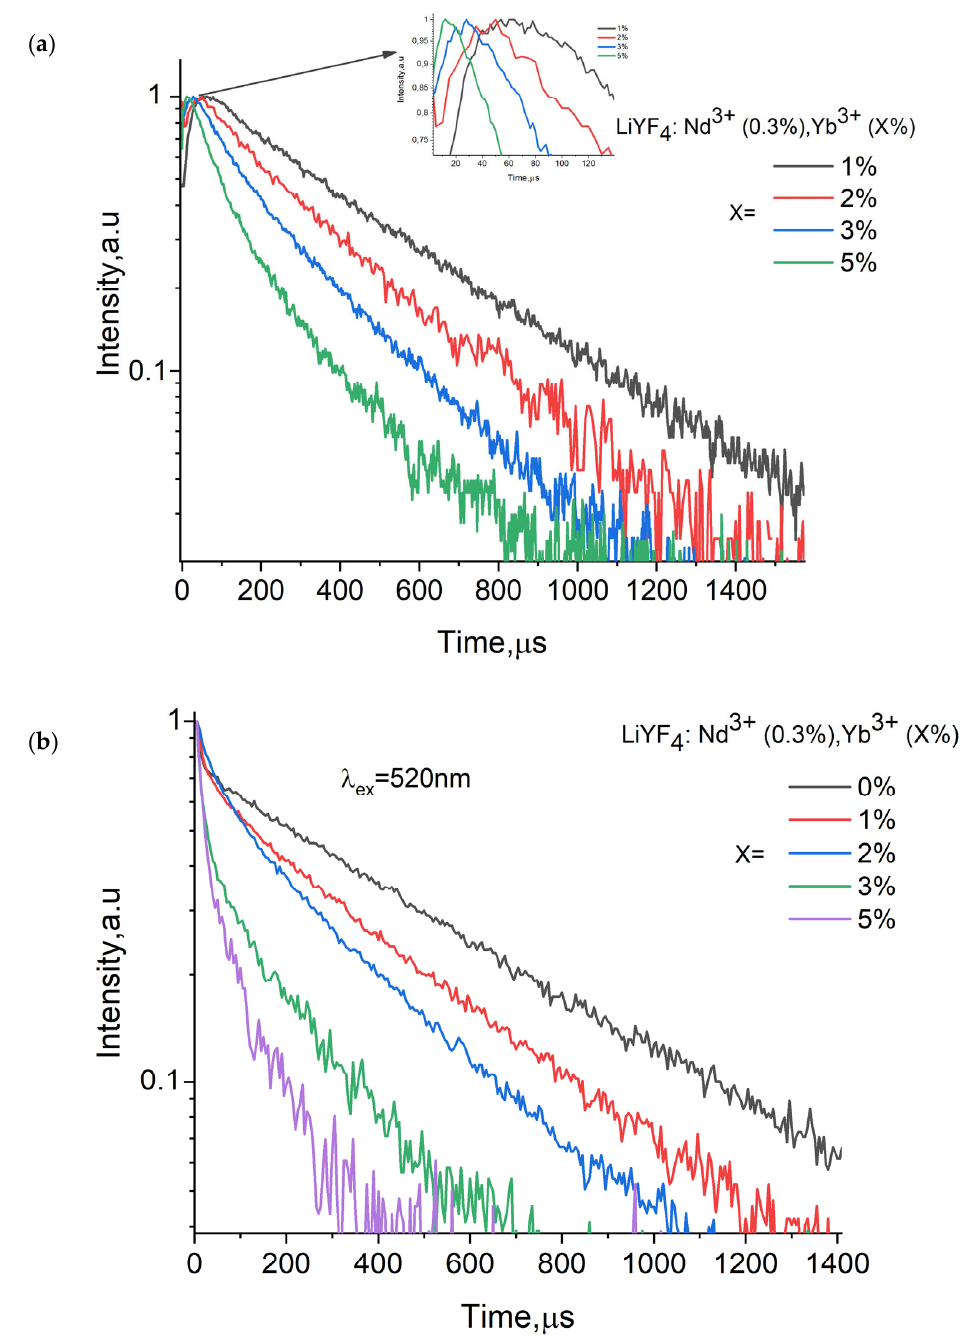
Figure 5. ( a ). Normalized room temperature lifetime curves of 4 F 3/2 – 4 I 9/2 emission of Nd 3+ (at 866 nm) in Nd 3+ (0.5%), Yb 3+ (1, 2, 3, and 5%):LiYF 4 phosphors. The excitation wavelength λ ex = 355 nm corresponds to 4 I 9/2 – 4 D 5/2 absorption band of Nd 3+ . The inset demonstrates the luminescence rising time as a function of the Yb 3+ concentration. ( b ). Normalized room temperature lifetime curves of 4 F 3/2 – 4 I 9/2 emission of Nd 3+ (at 866 nm) in Nd 3+ (0.5%), Yb 3+ (0, 1, 2, 3, and 5%):LiYF 4 phosphors. The excitation wavelength λ ex = 520 nm corresponds to 4 I 9/2 – 2 K 13/2 / 2 G 9/2 absorption band of Nd 3+ . As we can see, with an increase in the Yb 3+ concentration, the Nd 3+ luminescence lifetime decreased, which indicates an energy transfer from Nd 3+ to Yb 3+ . In addition, as mentioned above, the additional population of Nd 3+ and Yb 3+ levels may be related to cross ‐ relaxation. Indeed, the luminescence rising time curve at an excitation wavelength